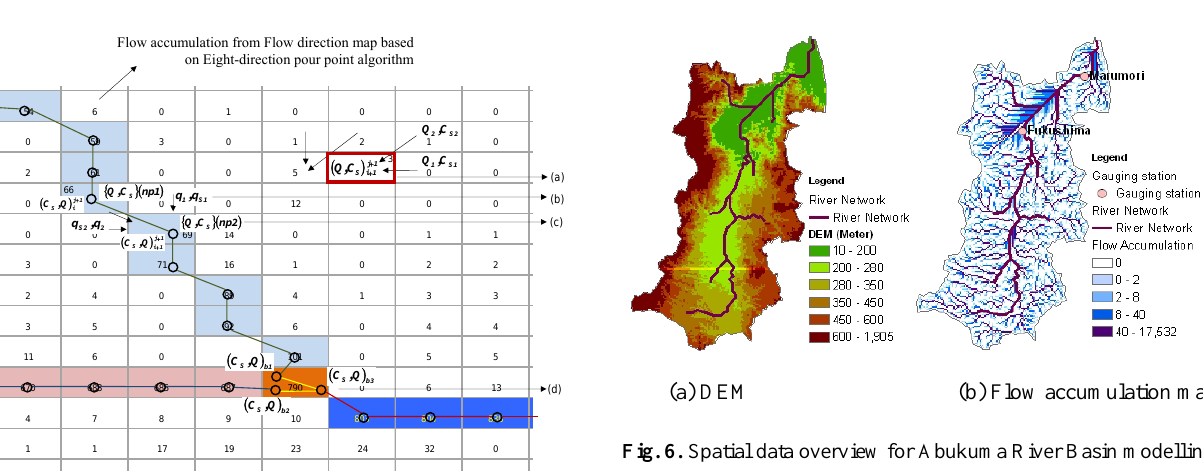
Fig. 3. Time and space derivatives of both Q and C s by finite-difference scheme in kinematic modeling (after Chow, 1959).